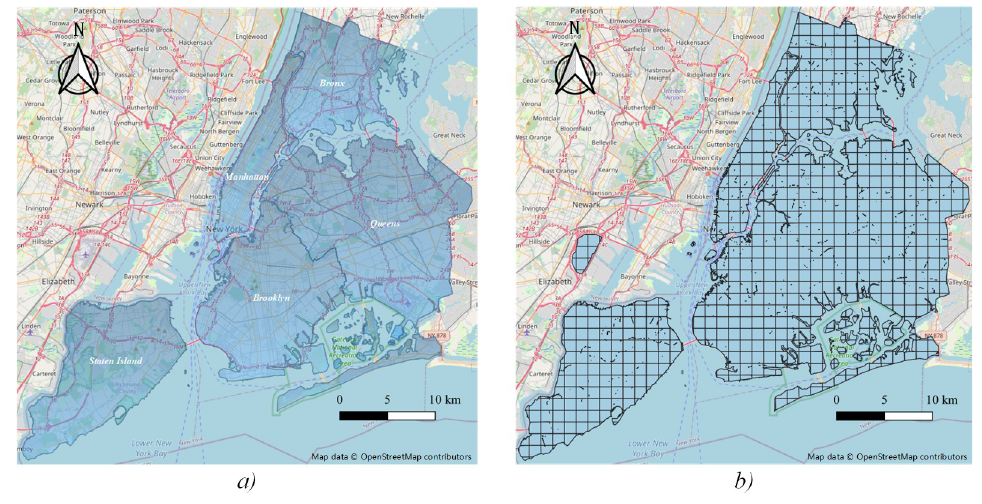
Fig 1. Layout and spatial division of study